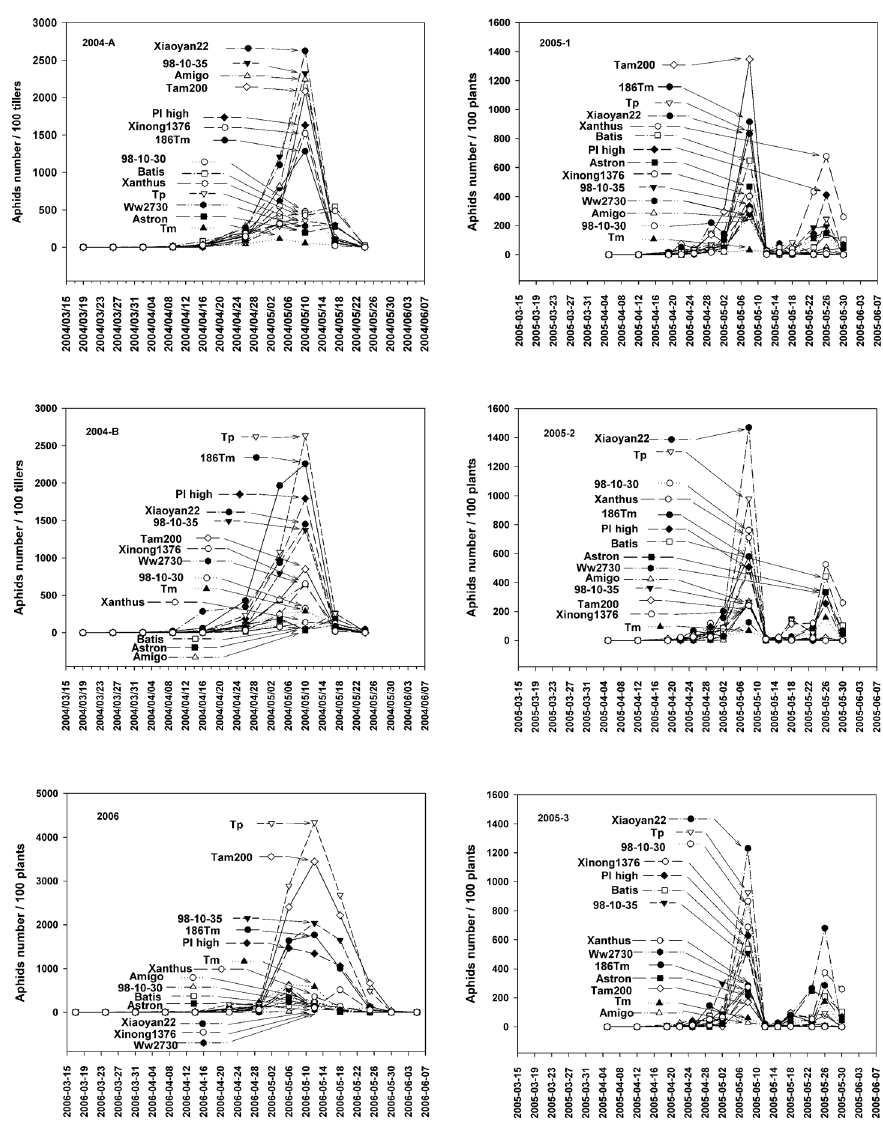
Fig 4. Population dynamics of S . avenae on 14 wheat varieties with 6 fields/sections over 3 years. ( F = 3.47, D . F . = 13, 336, p = 0.0004; F MAN ANOVA indicated no variation among the 6 fields/sections ( F